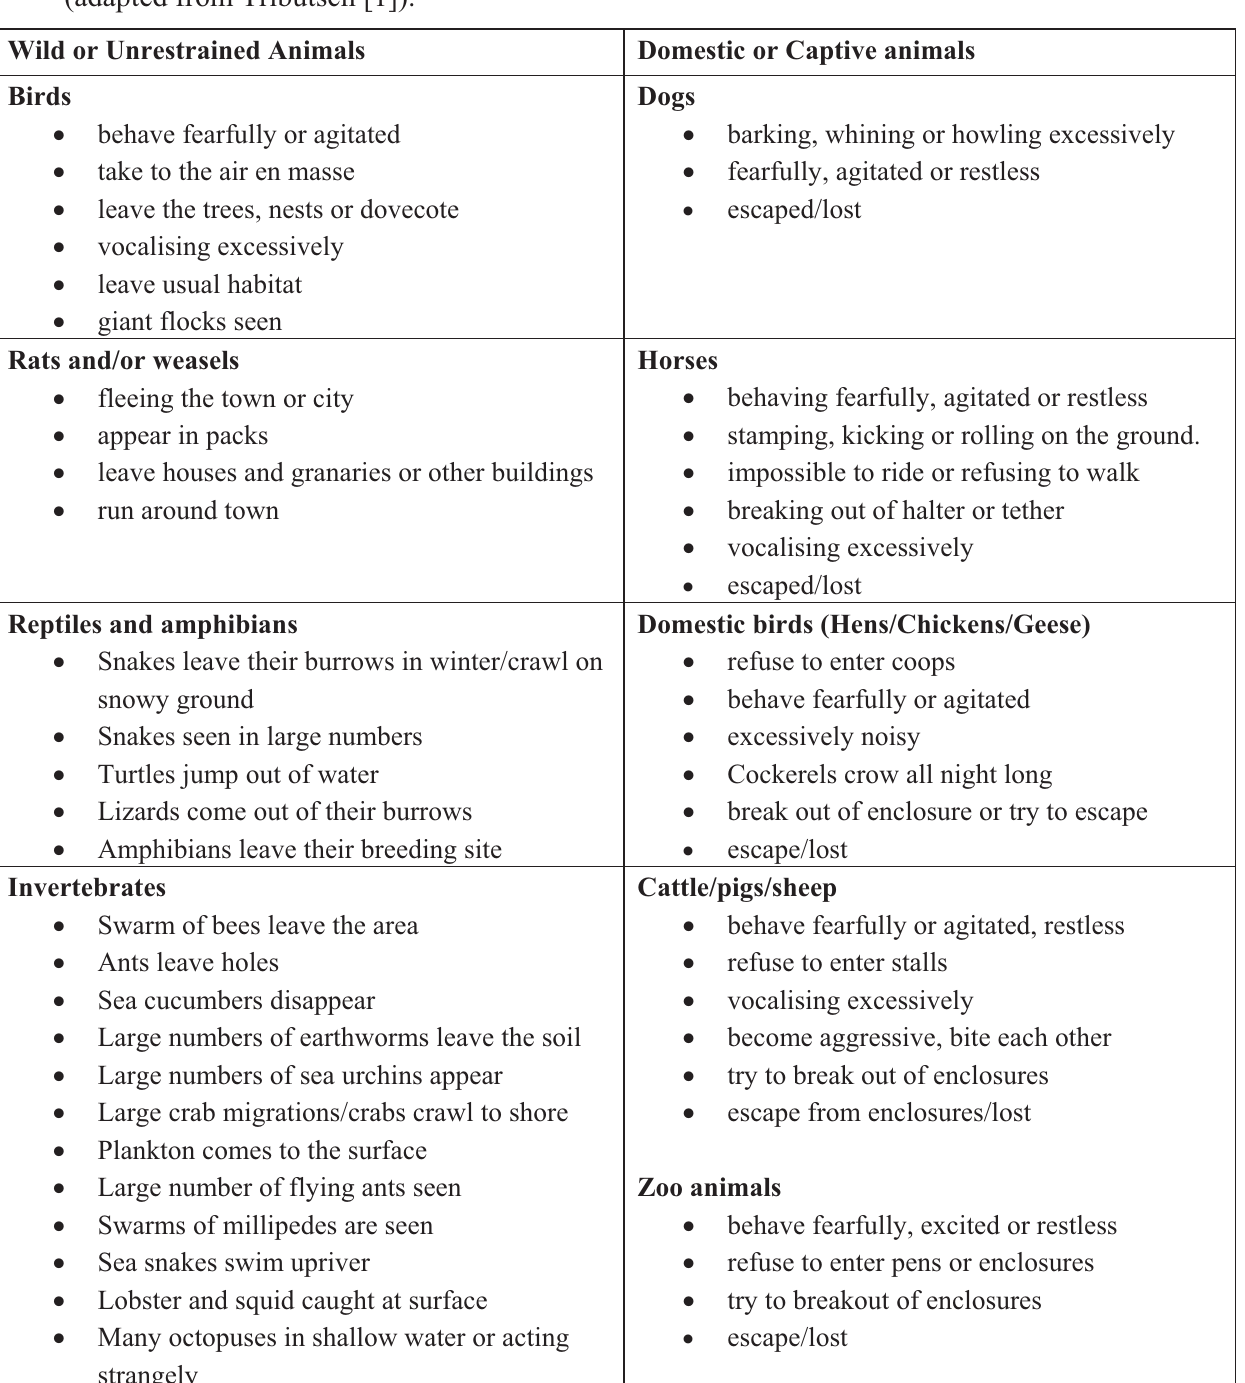
Table 2. Summary of Reponses of wild vs . domestic/captive animals prior to earthquakes (adapted from Tributsch